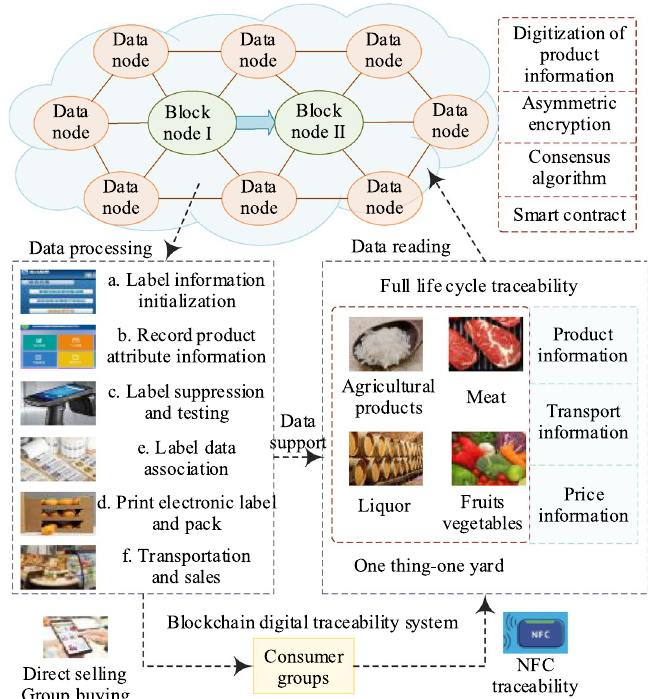
Figure 7. Operating procedure of the E-retail